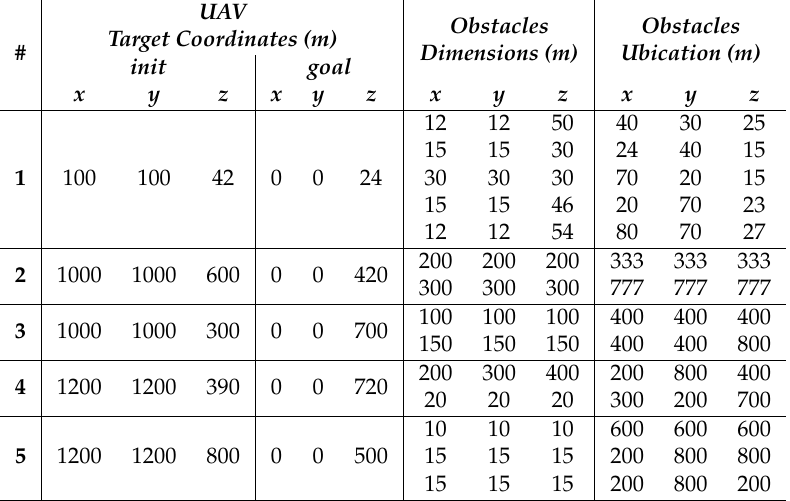
Table 4. Definition of five different 3D environments for the simulation examples.